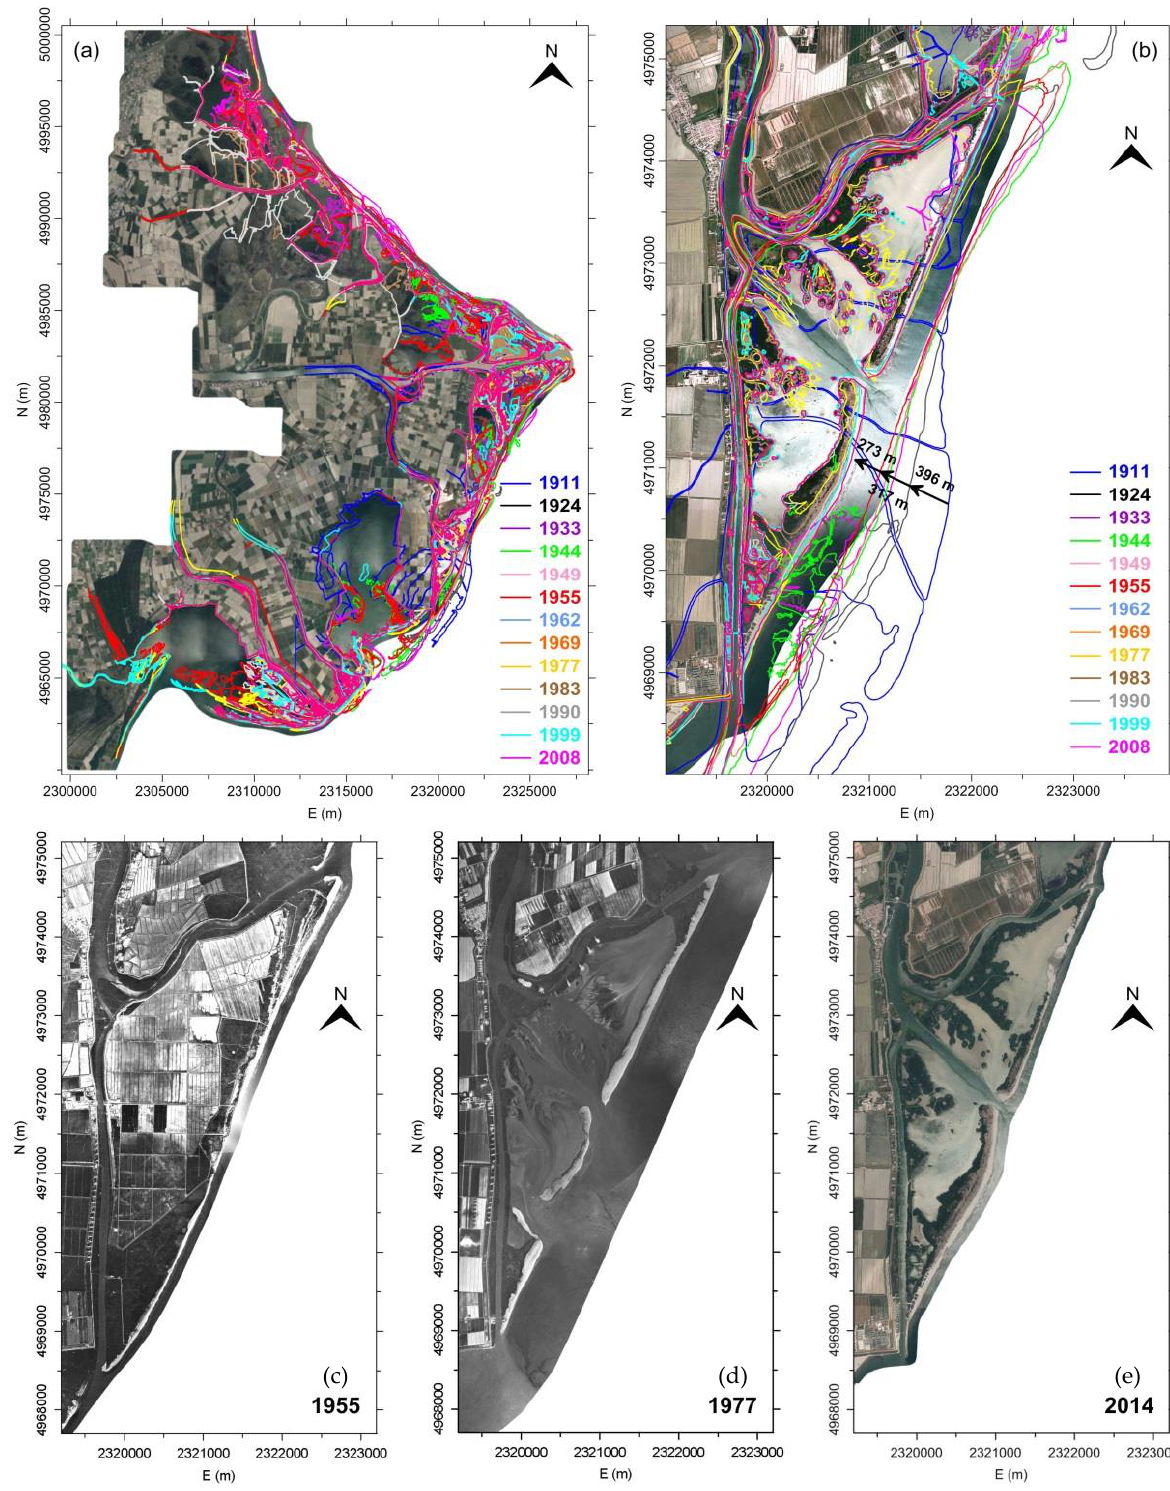
Figure 10. Coastline restitutions from archival cartography (1911–1924), photo-plans (aerial photogrammetric surveys performed in 1933, 1944, and 1949), and photogrammetric models (surveys carried out in 1955, 1962, 1969, 1977, 1983, 1990, 1999, and 2008) using stereoscopic devices were overlapped to the orthophoto of the last aerial photogrammetric survey (performed in 2014), ( a ) a detail related to the sub-area 3 (Bacino Bonelli Levante) is also shown ( b ) together with the orthophotos obtained from 1955 ( c ), 1977 ( d ), and 2014 ( e ) surveys, highlighting large deformations in emerged surfaces in the comparison 1955–1977.